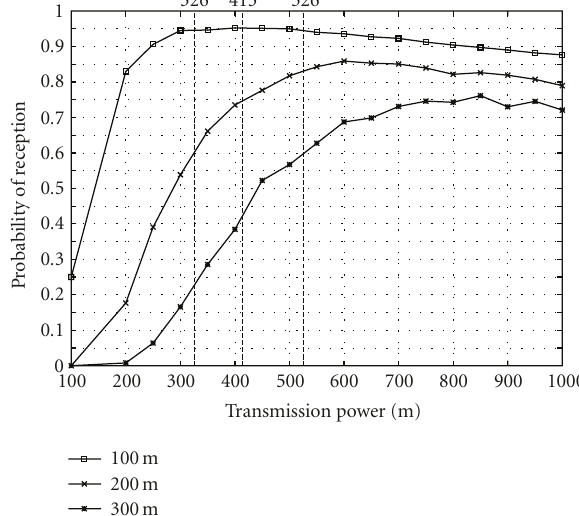
Figure 10: Scenario C (cf. Table 4). Probability of packet reception w.r.t. chosen power value: analytical computation (numbers) and simulative results